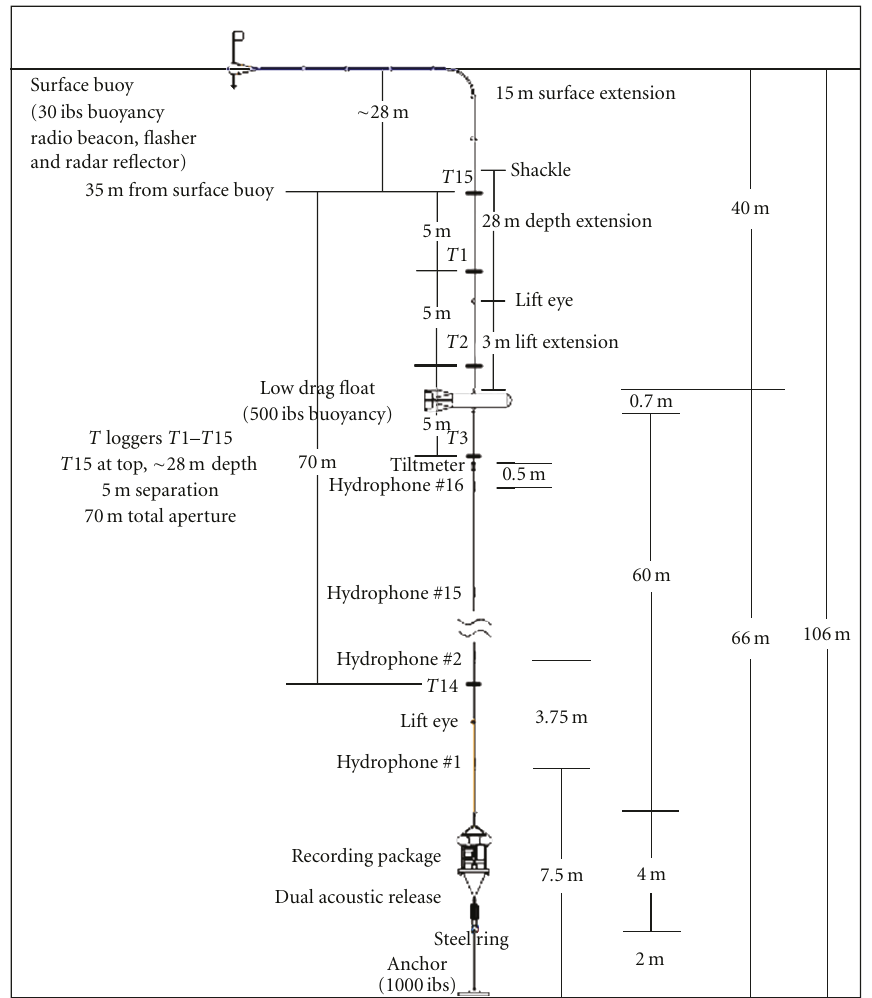
Figure 1: Scheme of the vertical array receiver adapted in the KAM08 experiment